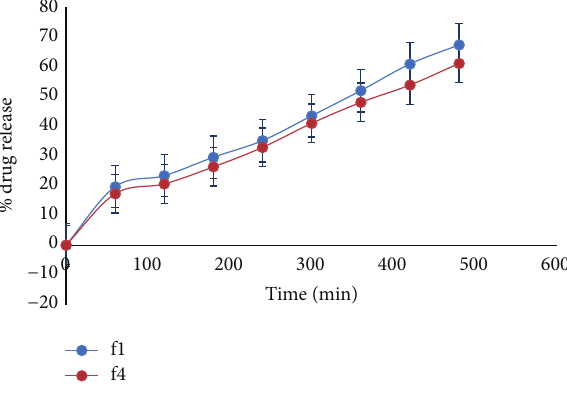
Figure 8: Ex vivo % drug release of formulations f1 and